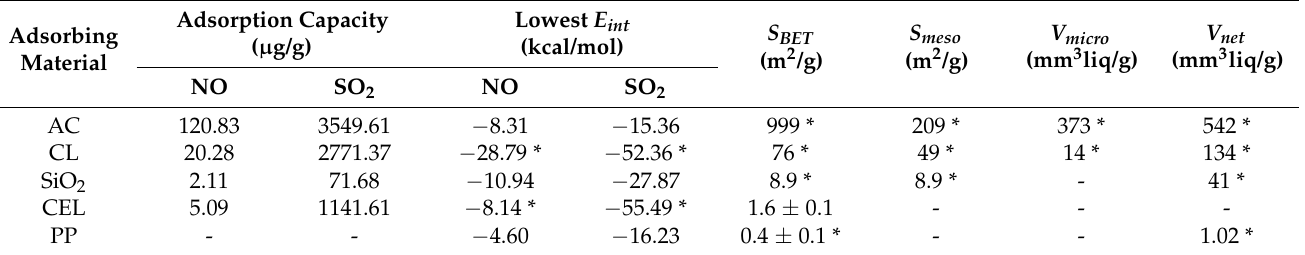
Table 4. Determining the importance of E int or textural properties ( S BET , S meso , V micro , V net ) on adsorp- tion capacity of the adsorbents having 0.16 – 0.315 mm granulometry.